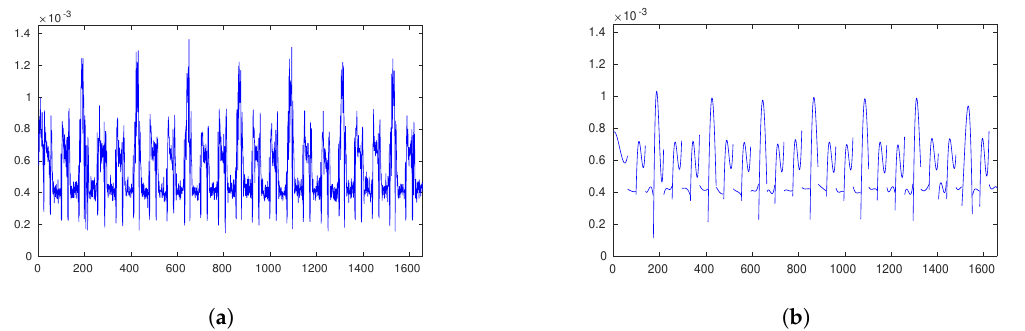
Figure 5. Time series and reconstruction with polynomial coefficients. ( a ) Time series; ( b ) Polynomially reconstructed time series.